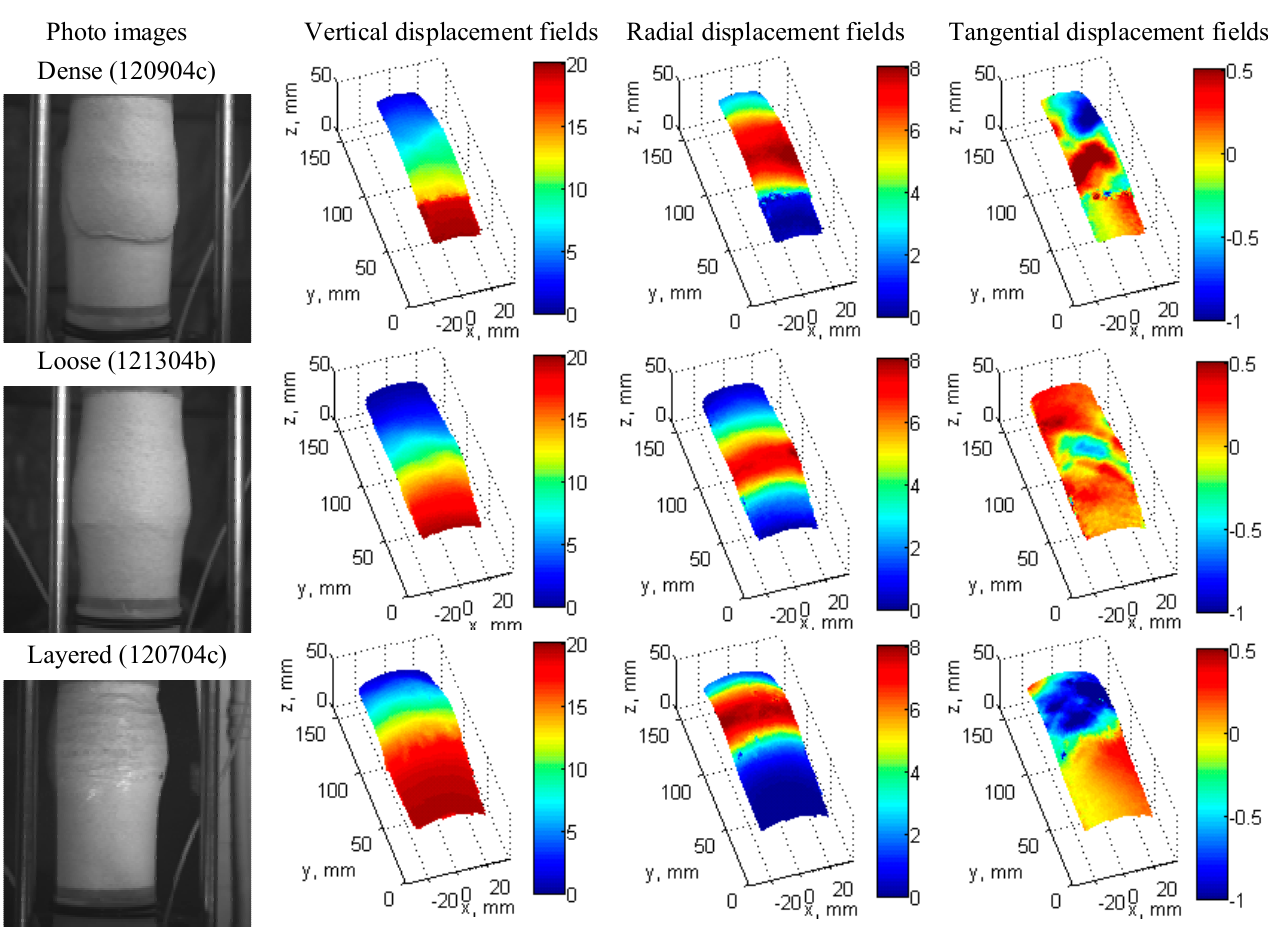
Figure 4. Photo images and cumulative displacement fields in mm at 12.0% of axial strain, representing the critical state.